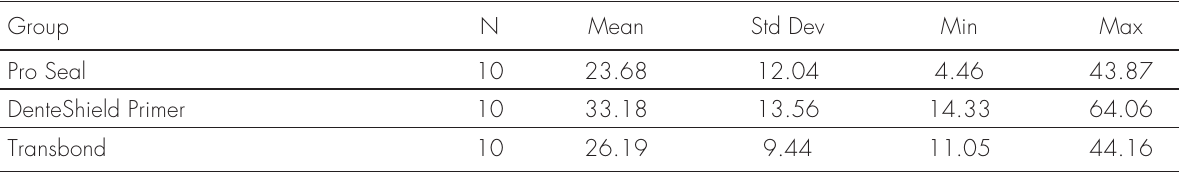
Table I. Shear bond strengths (MPa). Group